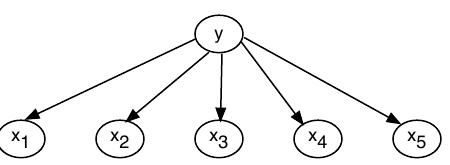
Figure 1. Example of the naive Bayesian network